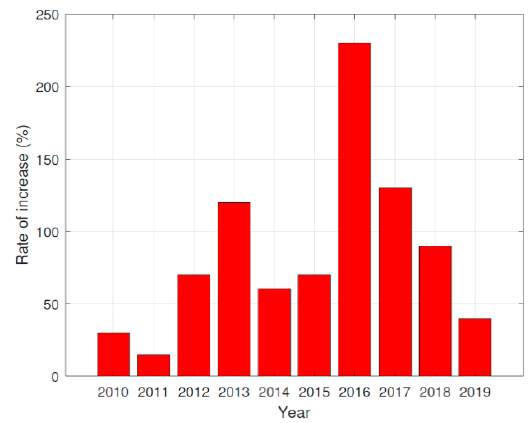
Figure 9. Rate of increase of fishing intensity relative to the estimated fishing mortality monthly